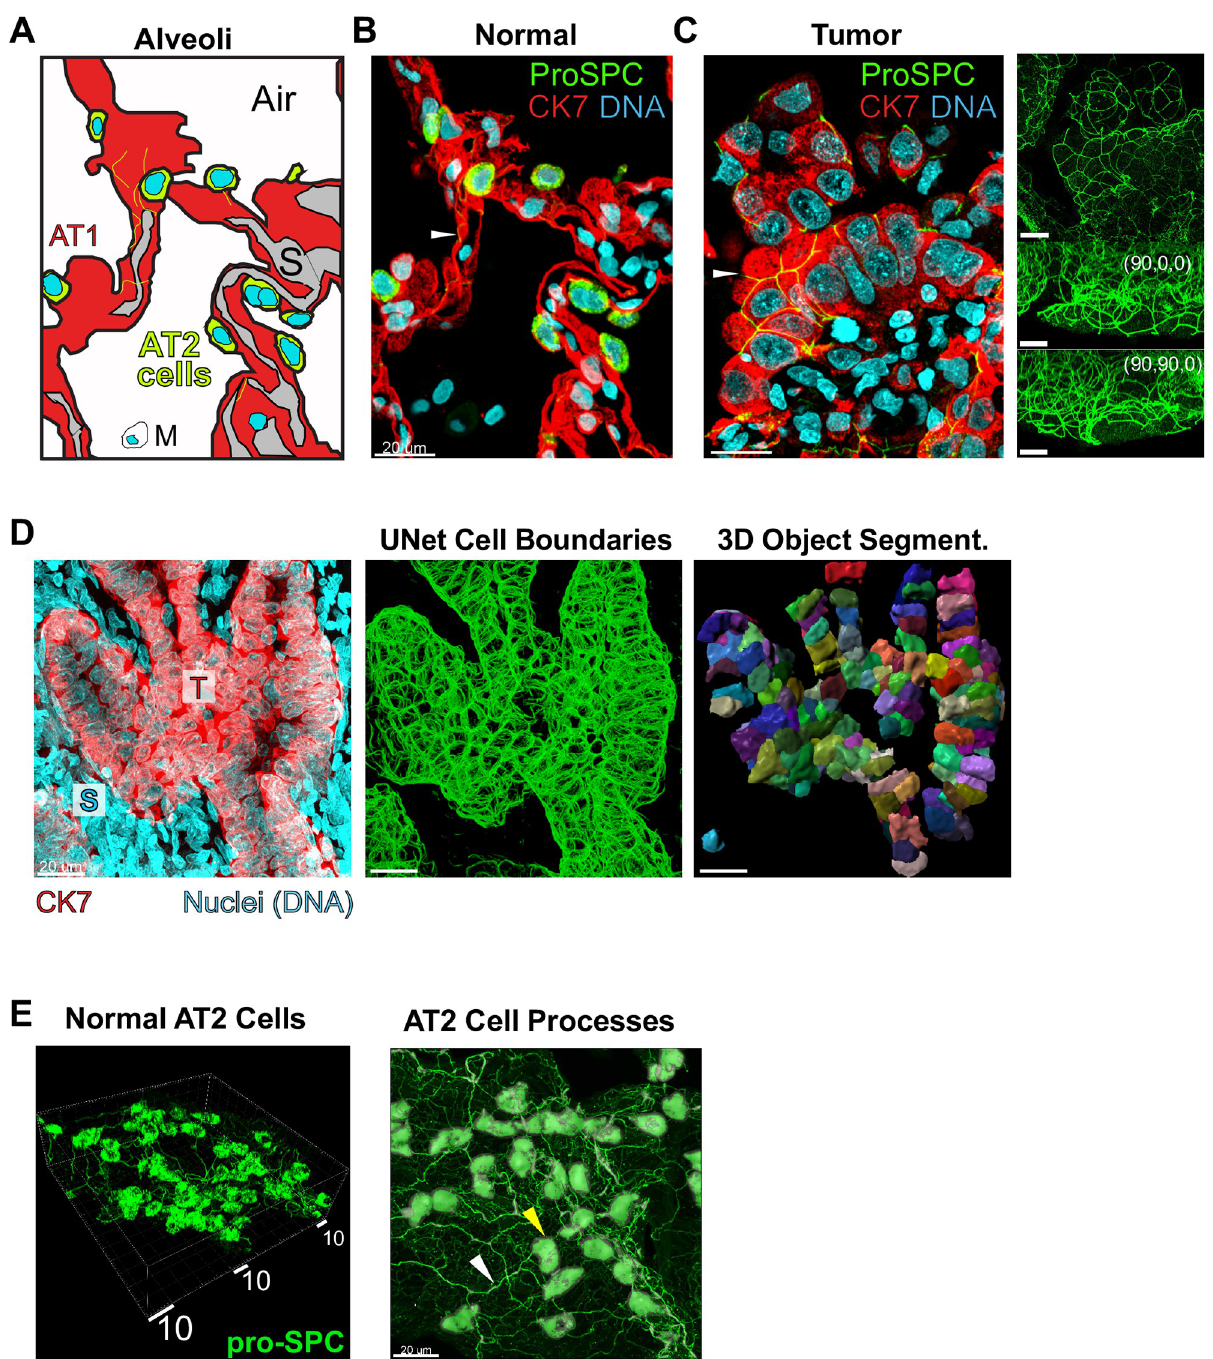
Fig 1. Human lung adenocarcinoma is characterized by dysregulation of cell and nuclear size. 63X images shown. A., schematized alveolus, related to B., showing AT2 cells (marker: proSPC, green), presumptive wide and flat AT1 cells, non-CK7-staining macrophage, M, and stroma, S. Epithelial cells express marker CK7, but weakly in AT2 cell bodies. B. and C., 5 μ m z-projections of representative normal distant control alveoli, B., and representative EGFR+ LA tumor, AT2 cells marked by proSPC (green), C. Cytokeratin 7, CK7 (red); overexpressed in tumor cells. DNA stained by TO-PRO-3 (cyan). White arrows: thin cellular processes (shown in 1E, below). Right, full-stack max-intensity projections from each axis. Scale bars, 20 μ m. Row D., 3D segmentation approach for tumor cells. Left, a high-density confocal stack often referenced during early development of our machine-learning algorithm. Middle, Machine Learning from CK7 staining predicts cell boundaries. Right, Commercial Imaris software fits cell boundaries, with rainbow coloring showing individually segmented cell surfaces. High-coverage case shown. E. Left, 3D rendering of AT2 cells (proSPC) showing thin cellular processes; right, processes shown with AT2 cell body segmentation (gray). White box shows perspective scale, 2 μ m per small tick mark. Yellow arrow: AT2 cell body; white arrow: cellular process.